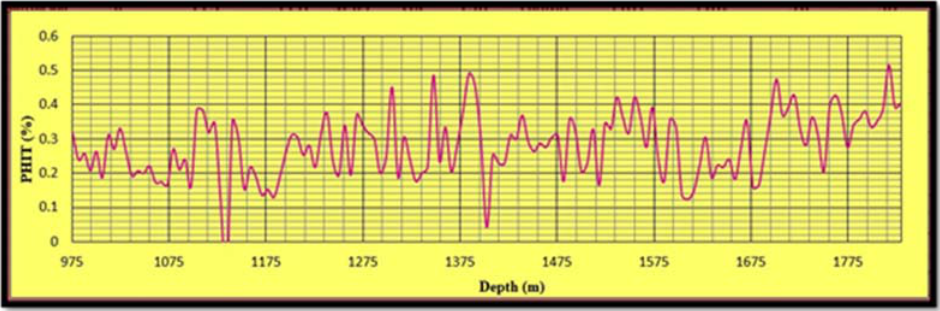
Figure 17. Total porosity variation along the depth.